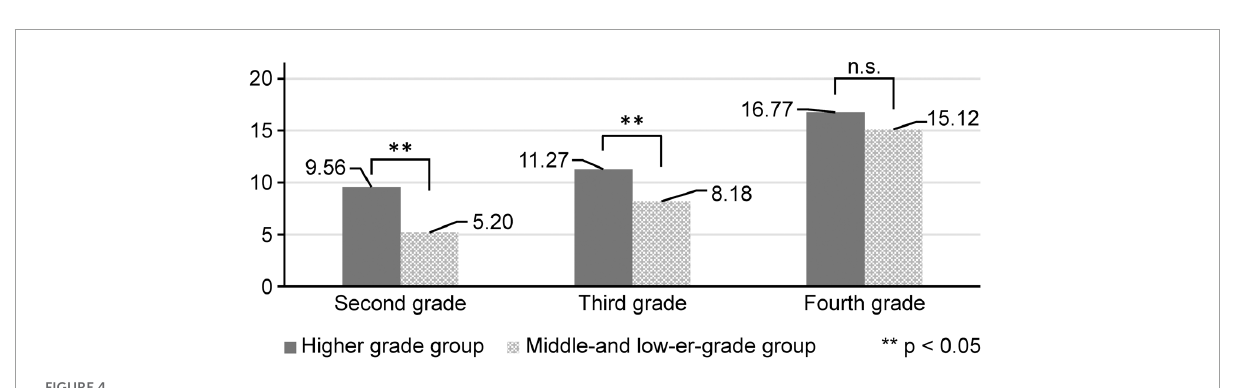
FIGURE4 Arts and crafts and softball throwing